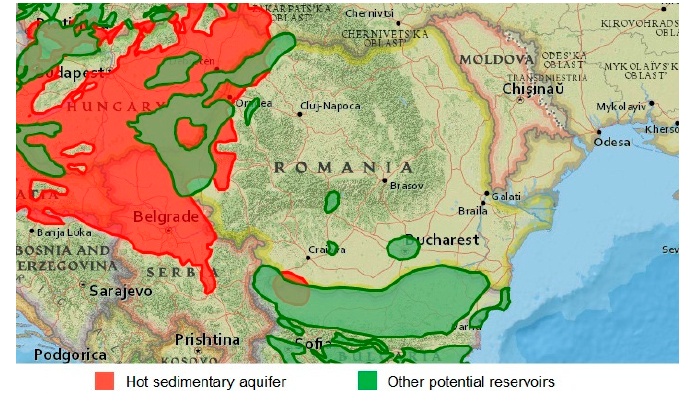
Figure 4. Distribution of the geothermal resources in Romania [20].